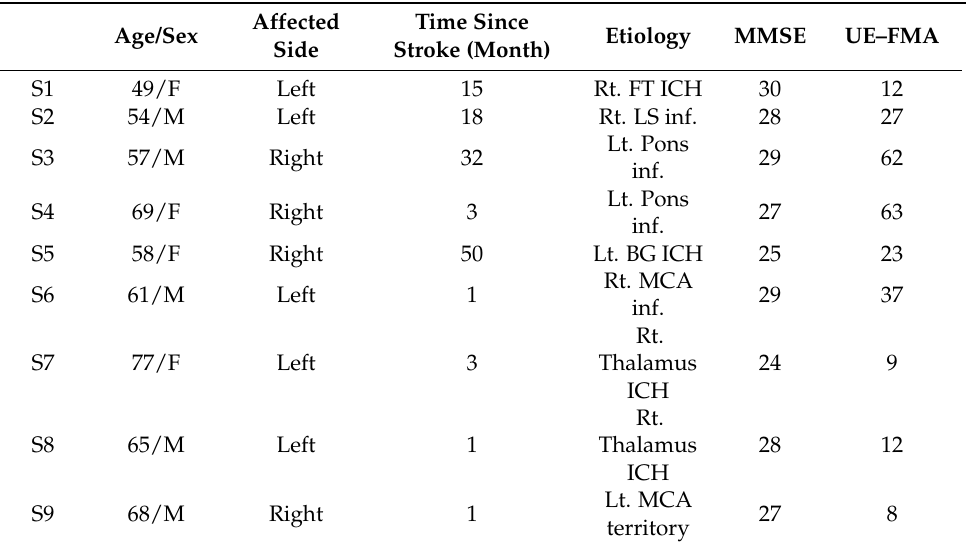
Table 7. Biographical information of participated stroke